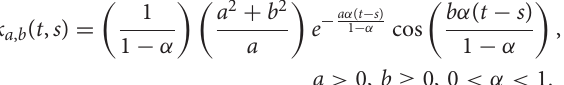
Frontiers in Physics | www.frontiersin.org